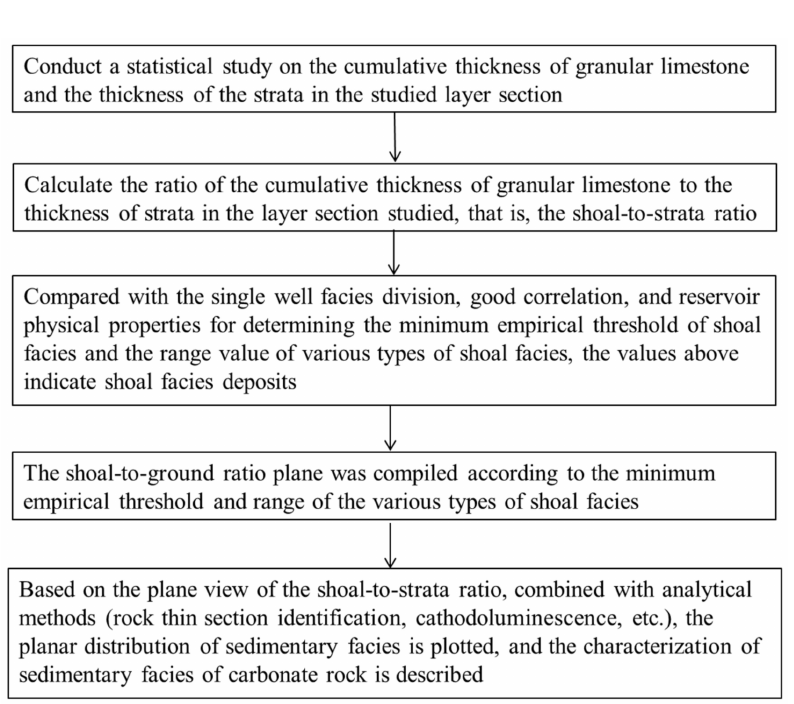
Figure 2. Flowchart of characterization of sedimentary facies of carbonate rocks using shoal-to- strata